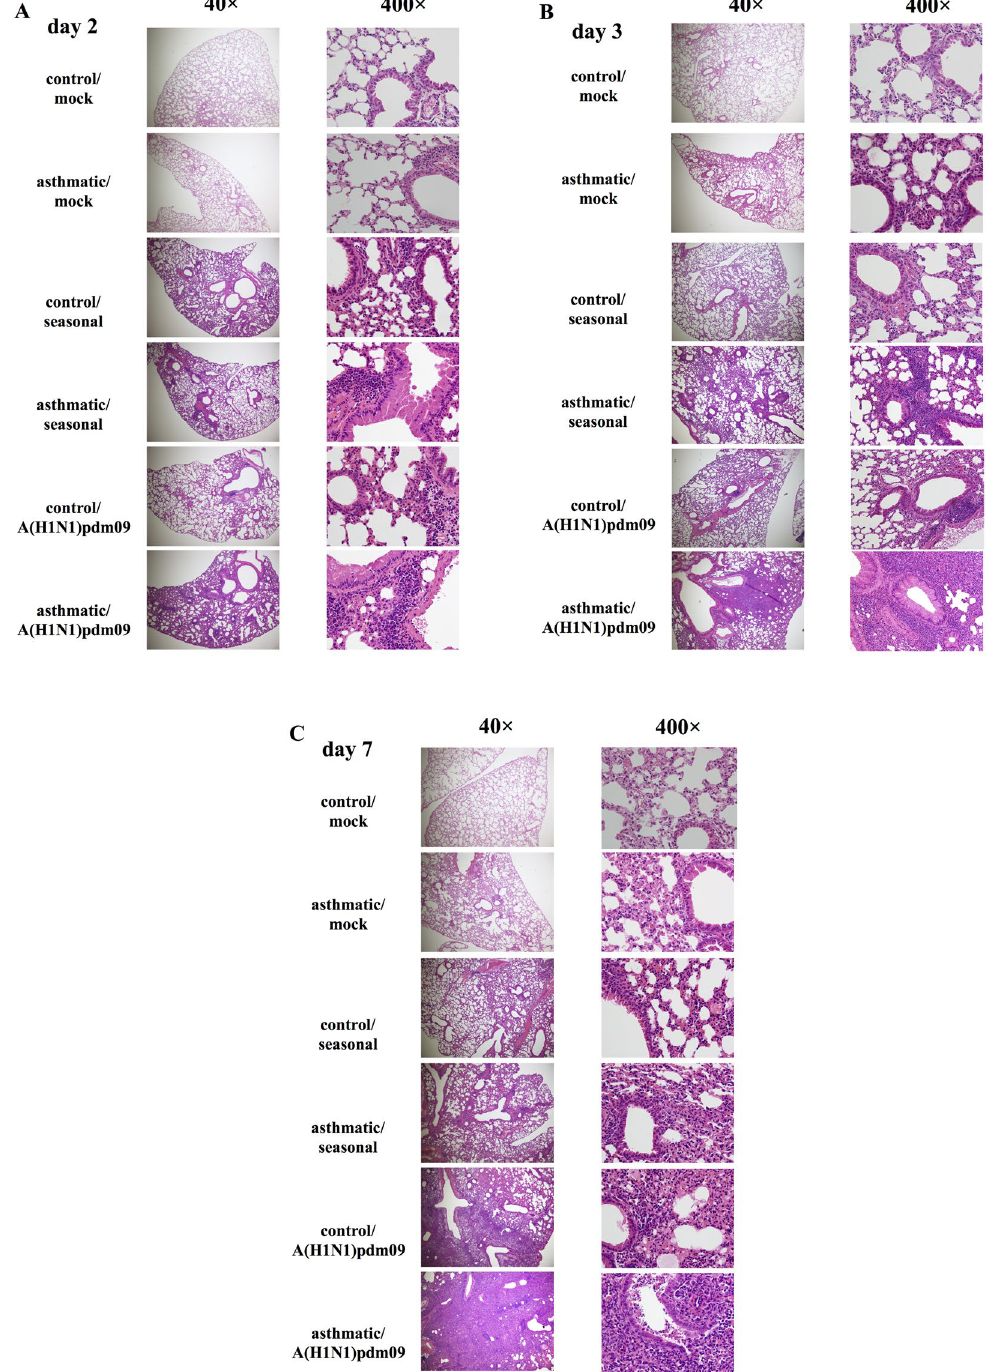
Figure 4. Histopathological findings after influenza infection. Photomicrographs of hematoxylin and eosin (H&E)-stained lung tissue at 2 ( A ), 3 ( B ), and 7 ( C ) days post-infection with mock, seasonal H1N1 (A/Puerto Rico) or A(H1N1)pdm09 influenza virus. Similar results were obtained in six independent mice from each group. Representative findings are